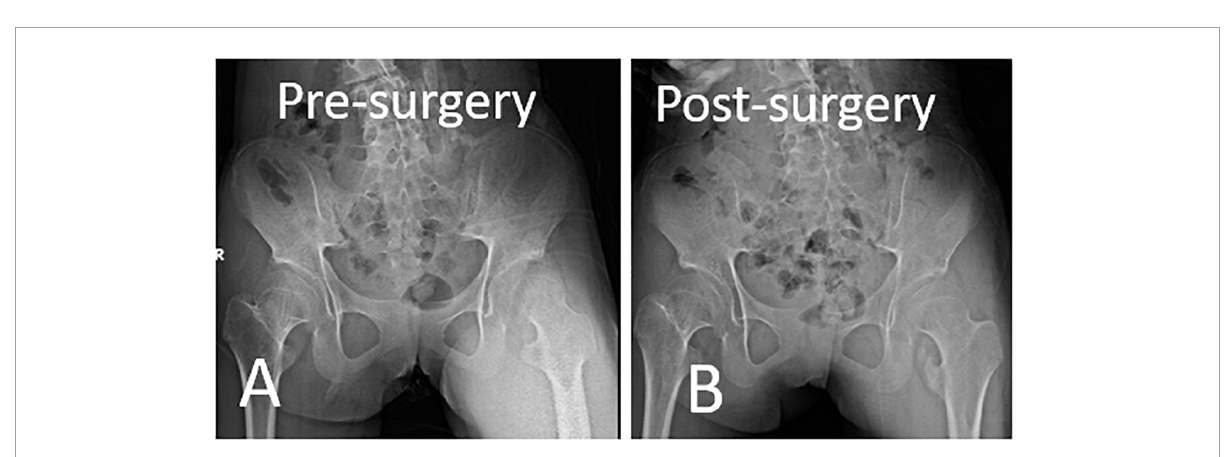
FIGURE8 Intraoperative removed ossification